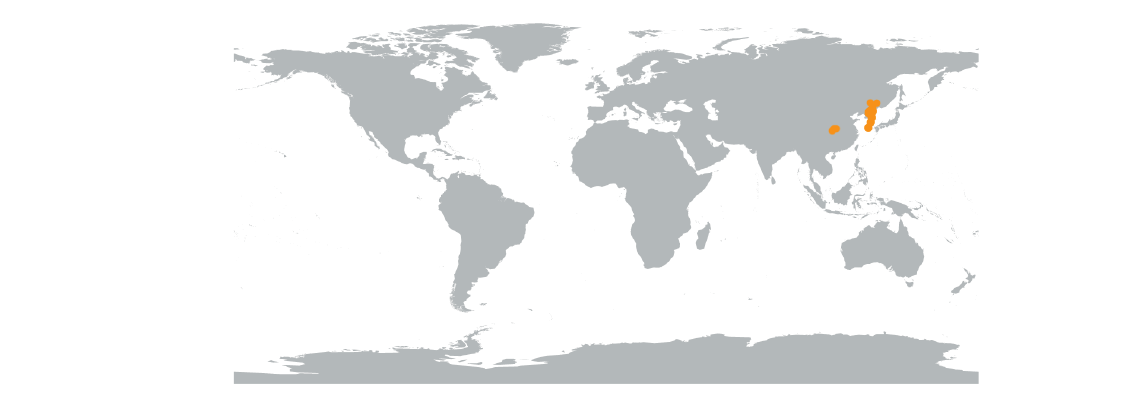
Fig. 59. Distribution of Malus komarovii (Sarg.)